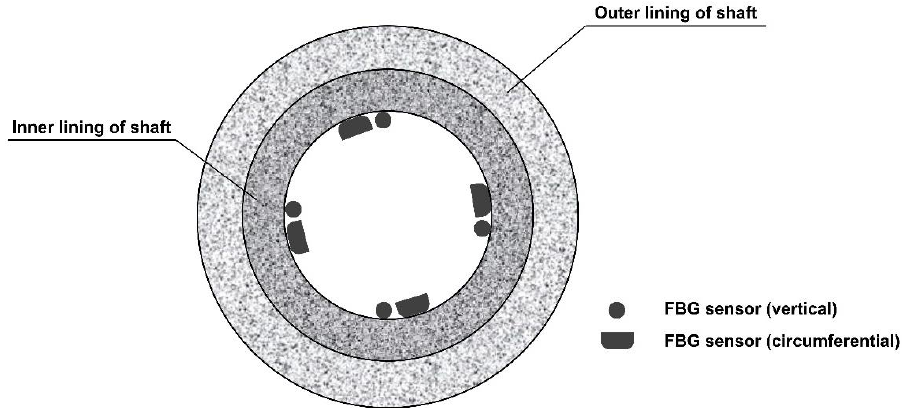
Figure 9. Schematic diagram of layout of FBG sensors.